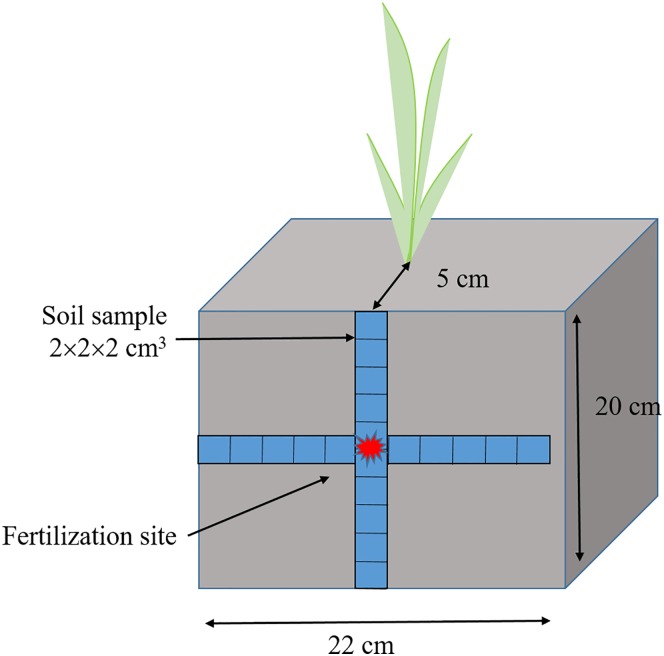
Diagram of soil sampling process.Red point means fertilizer site at 10cm depth. Each blue square means a 2×2×2 cm3 soil cube.